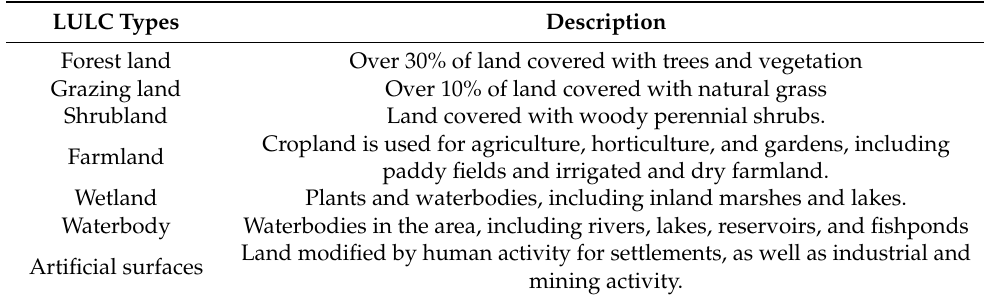
Table 1. Description of land-use and land cover types. LULC Types Description Forest land Over 30% of land covered with trees and vegetation Grazing land Over 10% of land covered with natural grass Shrubland Land covered with woody perennial shrubs. Cropland is used for agriculture, horticulture, and gardens, including Farmland paddy fields and irrigated and dry farmland. Wetland Plants and waterbodies, including inland marshes and lakes. Waterbody Waterbodies in the area, including rivers, lakes, reservoirs, and fishponds Land modified by human activity for settlements, as well as industrial and Artificial surfaces mining